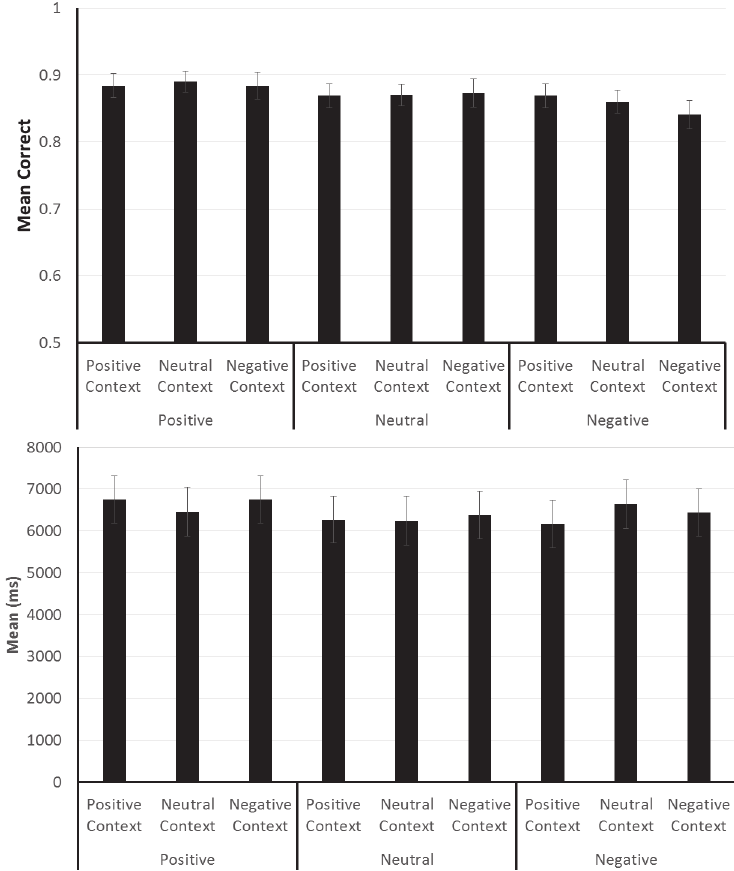
prospective memory task cues, and the valence of the pictures used for creating the positive, neutral and negative context conditions. The error bars represent the 95% confidence interval for each